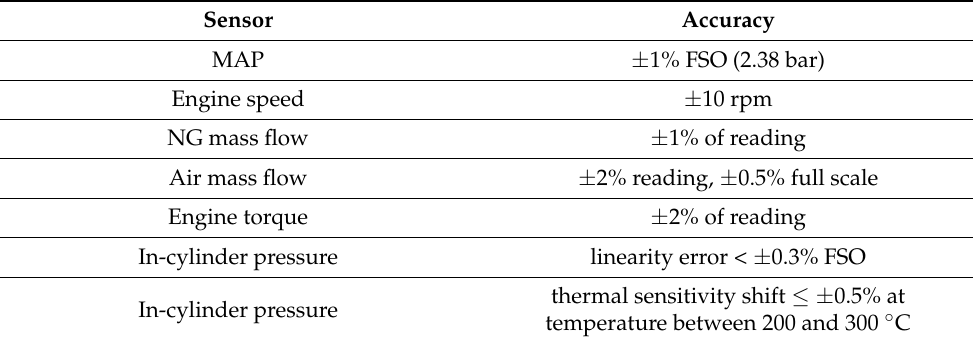
Table 6. Measurement accuracy of the instrumentation employed in the